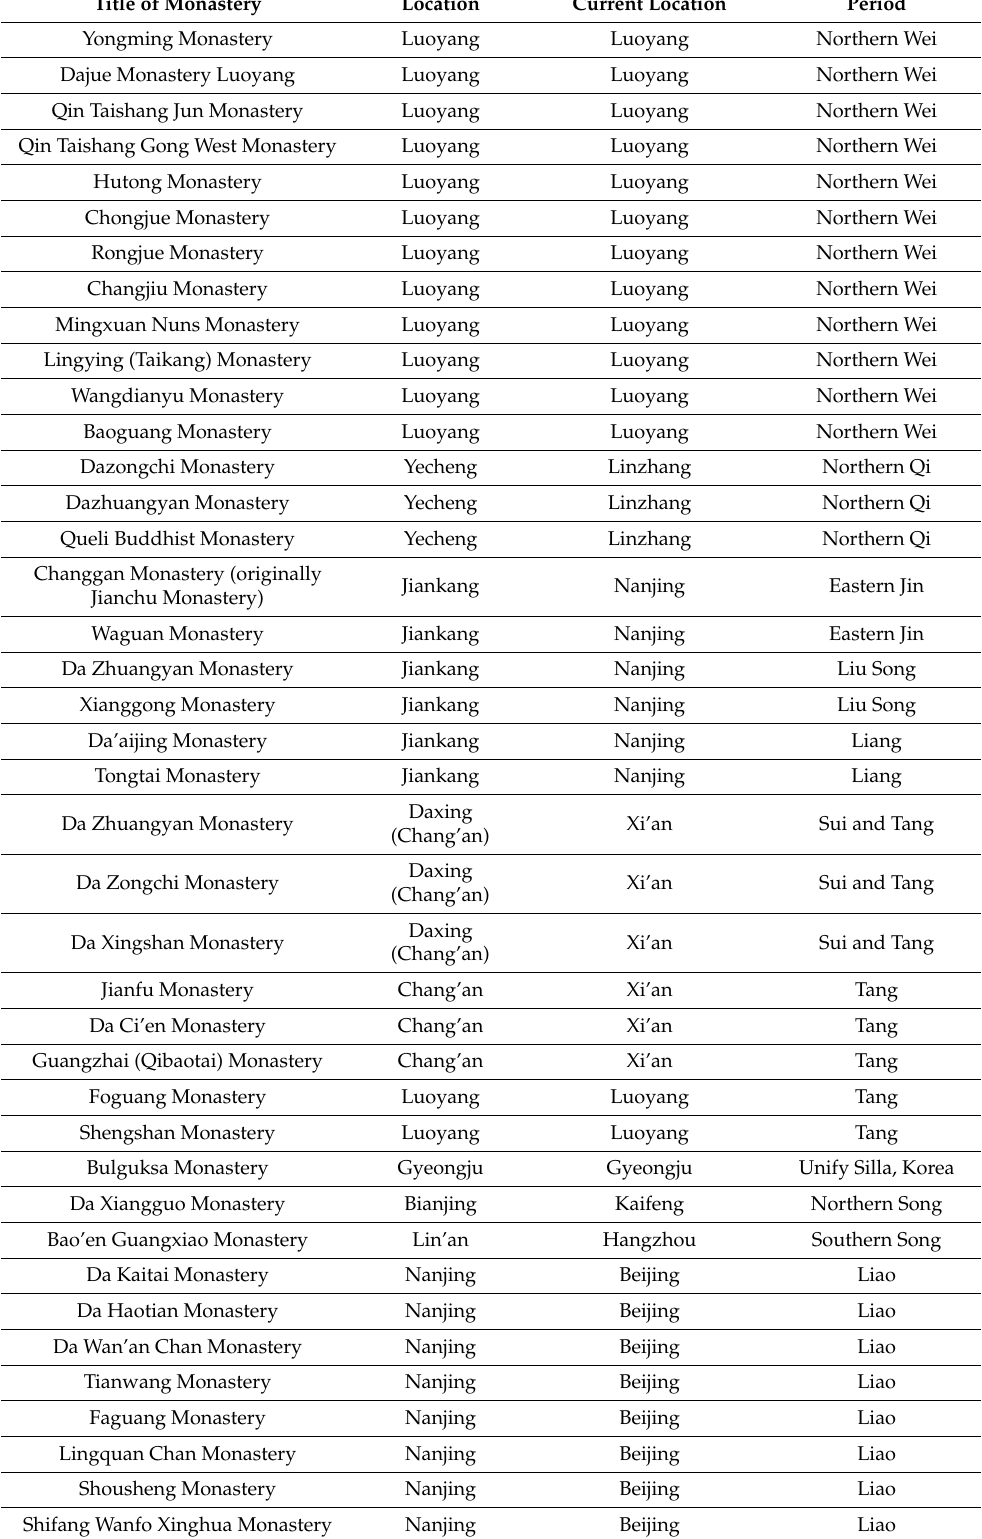
Table A1. Cont. Title of